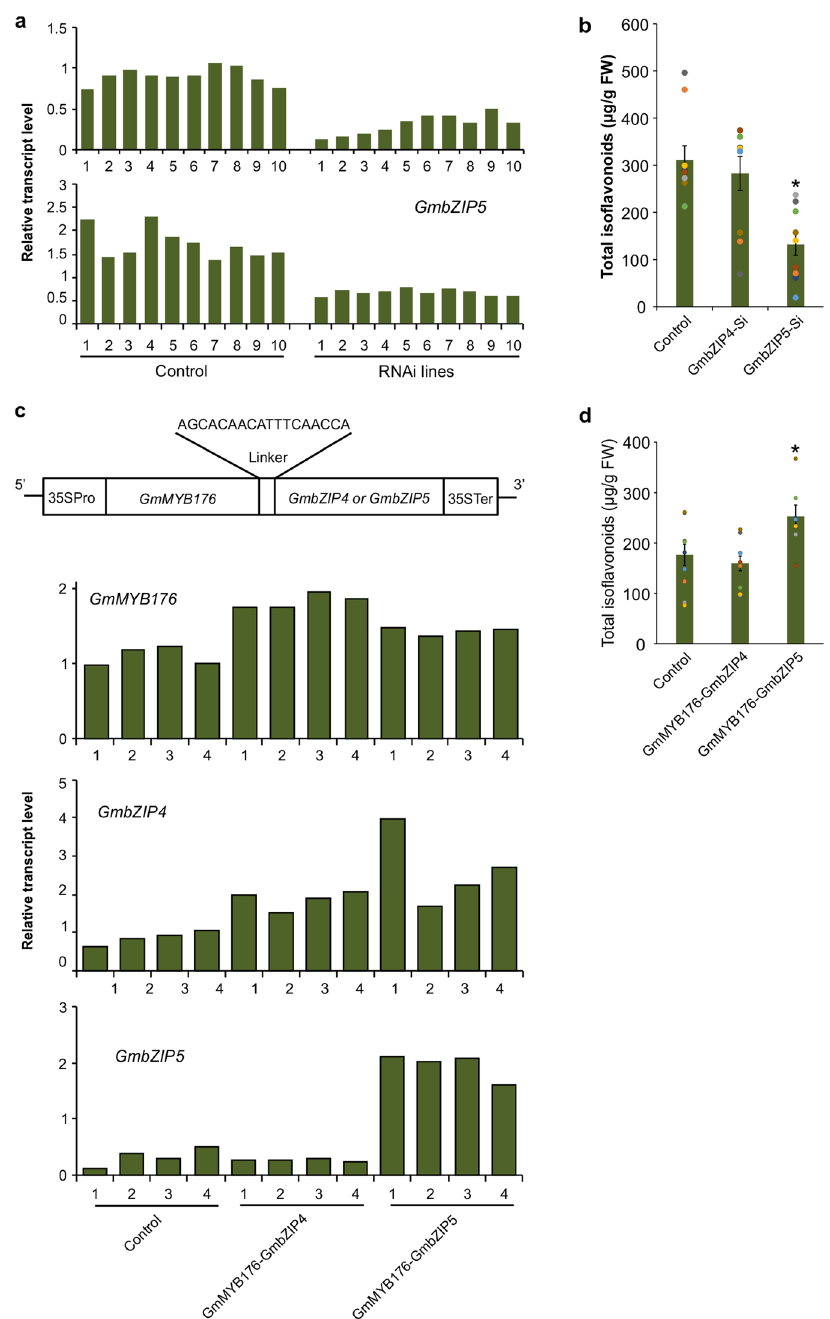
Fig. 3 Effect of GmbZIP silencing and overexpression of GmMYB176-GmbZIP fusion complex on iso fl avonoid level in soybean hairy roots. a Accumulation of GmbZIP4 and GmbZIP5 transcripts in multiple independent pools of transgenic or control hairy root samples determined by quantitative (q) RT-PCR. Values were normalized against the CONS4 reference gene. b Effect of RNAi silencing of GmbZIP4 (GmbZIP4-Si) or GmbZIP5 (GmbZIP5-Si) on iso fl avonoid content using hairy roots. Control indicates untransformed hairy roots. Data correspond to mean iso fl avonoid levels in ten biological replicates. The asterisk (*) denotes statistically signi fi cant expression (one-tail t test, p < 0.0001). c Schematic diagram showing GmMYB176-GmbZIP4 and GmMYB176-GmbZIP5 gene fusion for overexpression in soybean hairy roots. Expression levels of the gene fusion were determined by qRT-PCR in multiple independent pools of control or transgenic roots normalized against the reference gene CONS4 . Control indicates untransformed hairy roots. d Effect of overexpression of GmMYB176-GmbZIP4 or GmMYB176-GmbZIP5 on iso fl avonoid levels. Data correspond to mean iso fl avonoid levels in ten biological replicates. The asterisk (*) denotes statistically signi fi cant expression (one-tail t test, p < strength of YFP signal in the protein – protein interaction between detected (Supplementary Data 1) and 29 candidates were cate- GmbZIP5 and GmMYB176S29A (Fig. 2c) suggests the possibility of unphosphorylated GmMYB176 as the activator. Among the GmMYB176 interactors obtained from the Co-IP experiment, several protein kinase and phosphatase family members were